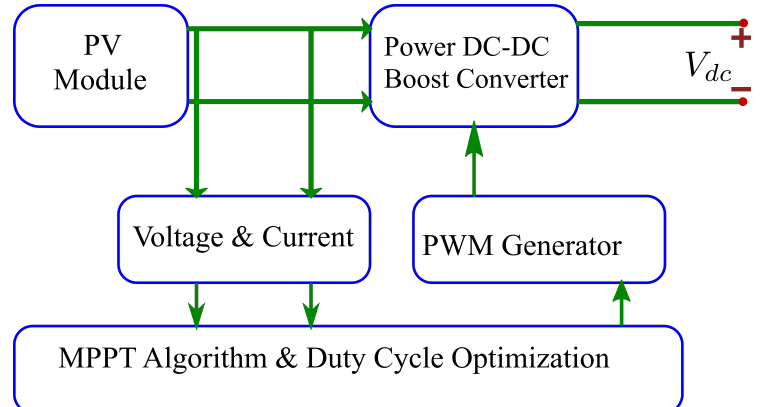
Figure 9. Block diagram indicating the MPPT control structure.